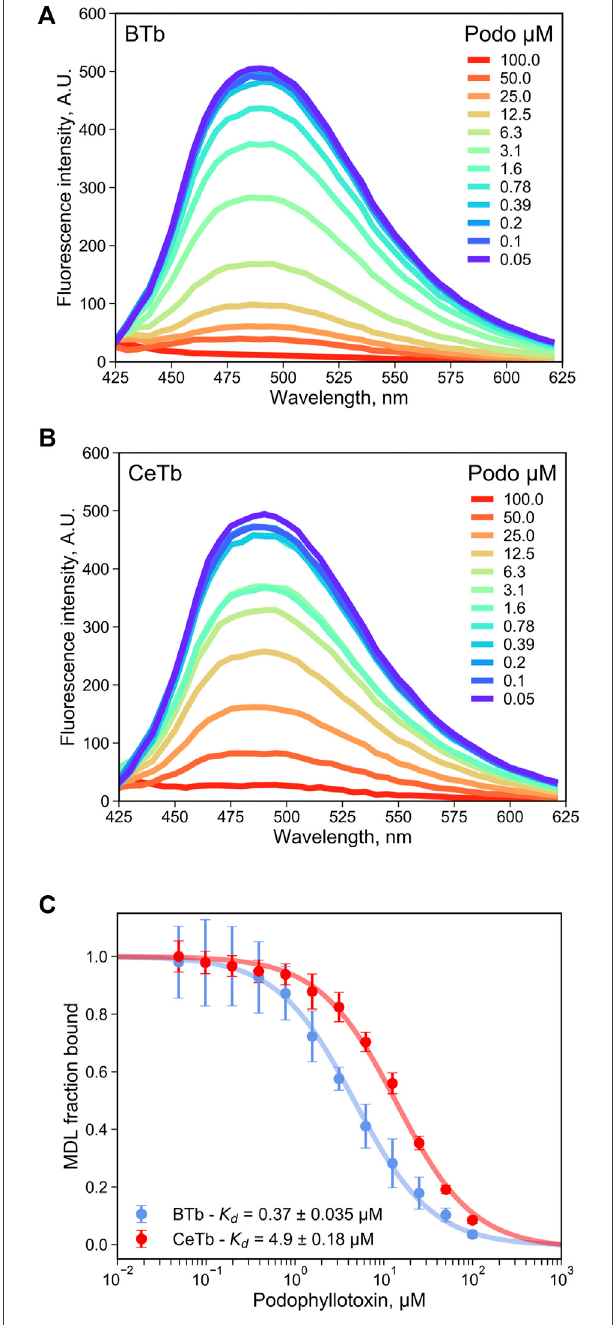
FIGURE 5 | Determination of the dissociation constant for tubulin — podophyllotoxin interaction by competition experiments. The fl uorescence of tubulin-bound MDL gradually decreases upon displacement by the competitor podophyllotoxin as monitored by the fl uorescence emission spectra with excitation at 400 nm, for tubulin from brain (A) or from erythrocytes (B) . (C) the podophyllotoxin concentration-dependent change in the fl uorescence intensity at 550 nm was used to determine the apparent dissociation constant by non-linear regression using Eq. 4 . 1 µM tubulin with